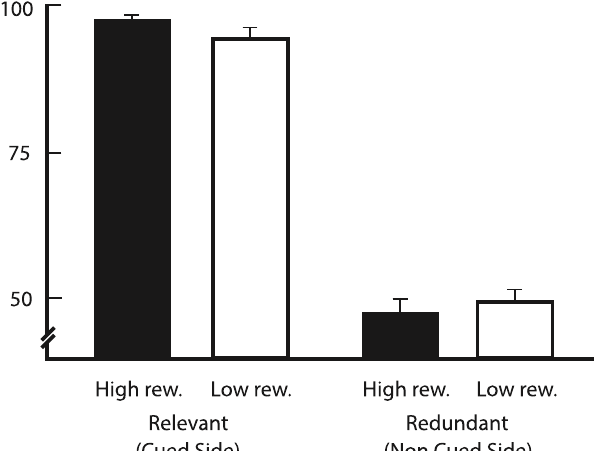
In summary, we found that RTs were generally faster and accuracies higher for attended shapes that were paired with high reward during the learning phase.